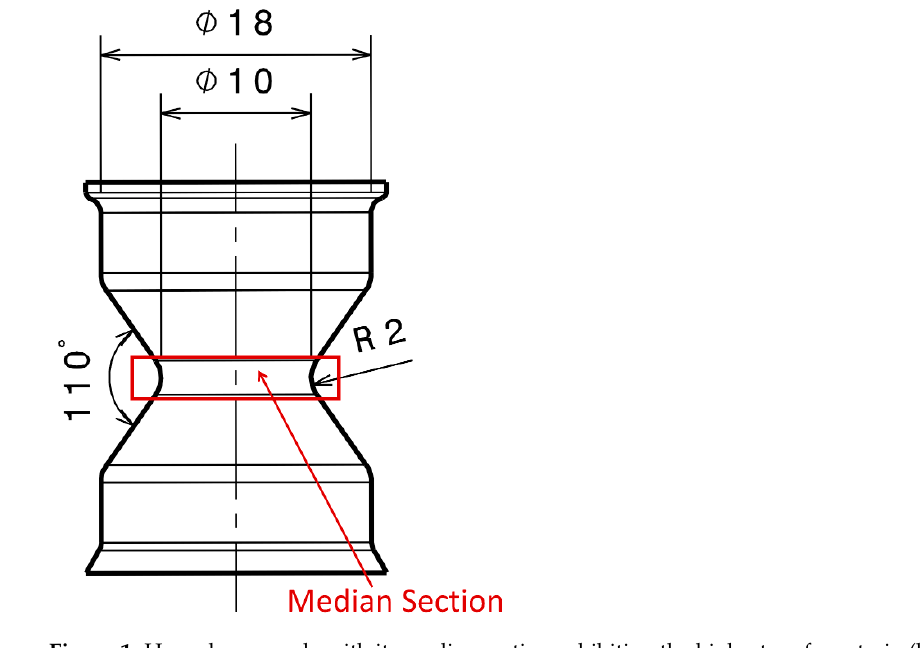
Figure 1. Hourglass sample with its median section exhibiting the highest surface strain (highlighted with the red rectangle) upon loading.